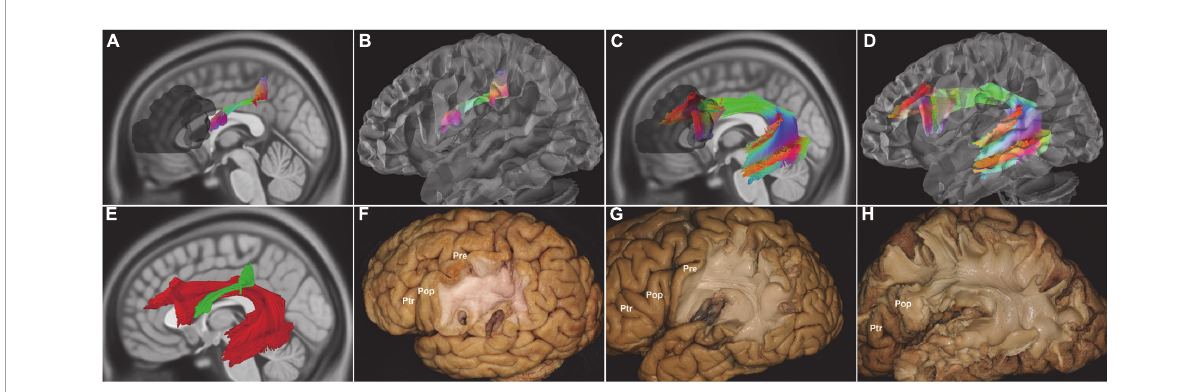
FIGURE3 In vivo fiber tractography of the SLF-III and AF (HCP-842). (A,B,F) In vivo fiber tractography and fiber microdissection of the SLF-III. SLF-III connected the supramarginal gyrus with the ventral part of the precentral gyrus and Pop. (C,D,H) In vivo fiber tractography and fiber microdissection of the AF. The AF connected Broca’s area with the lateral temporal cortex via a dorsal projection arched around the Sylvian fissure. (E,G) Spatial relationship of the SLF-III and AF. The fibers of the SLF-III had a horizontal orientation laterally to the AF. AF, arcuate fascicle; SLF-III, superior longitudinal fasciculus III; Pop, pars opercularis; shadow area, Broca’s